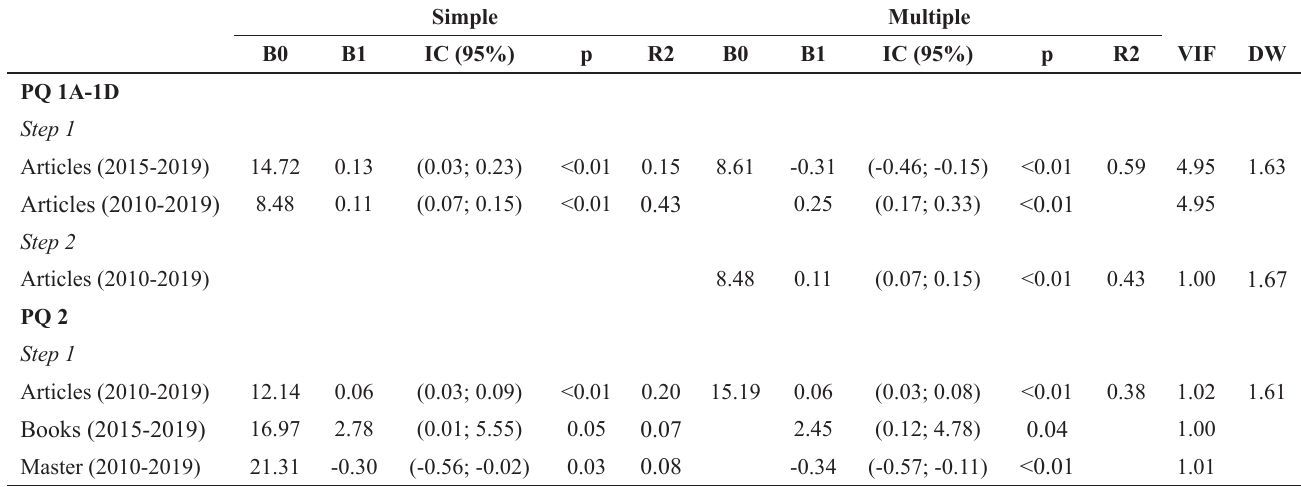
Table 5 - Simple and multiple linear regression analysis between H Index and respective predictors for CNPq Productivity Researchers in the field of Physical Education,